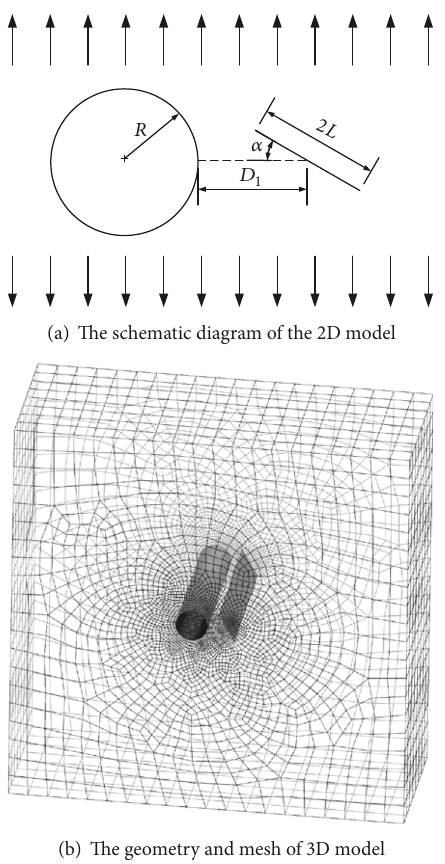
Figure 7: The comparison between the result from the 3D model in Figure 6 and the 2D theoretical